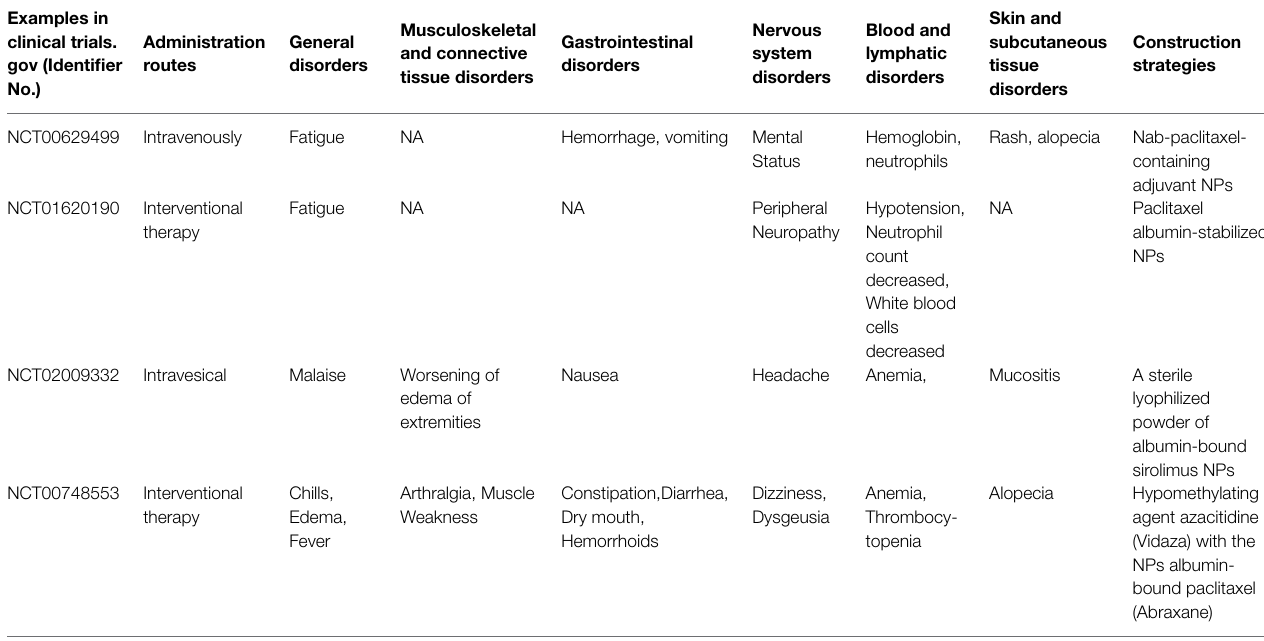
TABLE 2 | Examples of NPs inducing potential complications and adverse events in some clinical trials. Examples in clinical